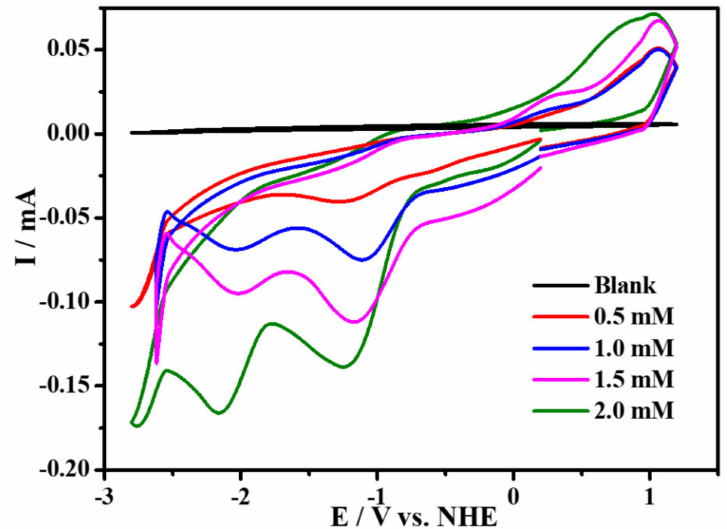
Figure 6. Cyclic voltammograms of the complex 1 at different concentrations in the CO 2 atmosphere. Scan rate: 100 mV s − 1